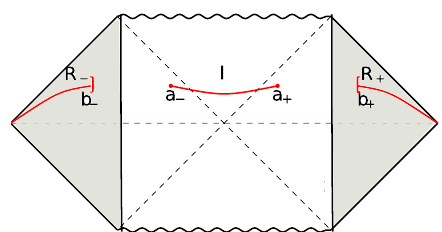
Figure 3 . The AdS black hole+Bath system. The bath (colored region) plays the role of the environment around the evaporating black hole. This is necessary to include this environment since the boundary of AdS is reflecting and as a result of that the evaporation will be terminated at some point due to the expected equilibrium between the emission and the absorption